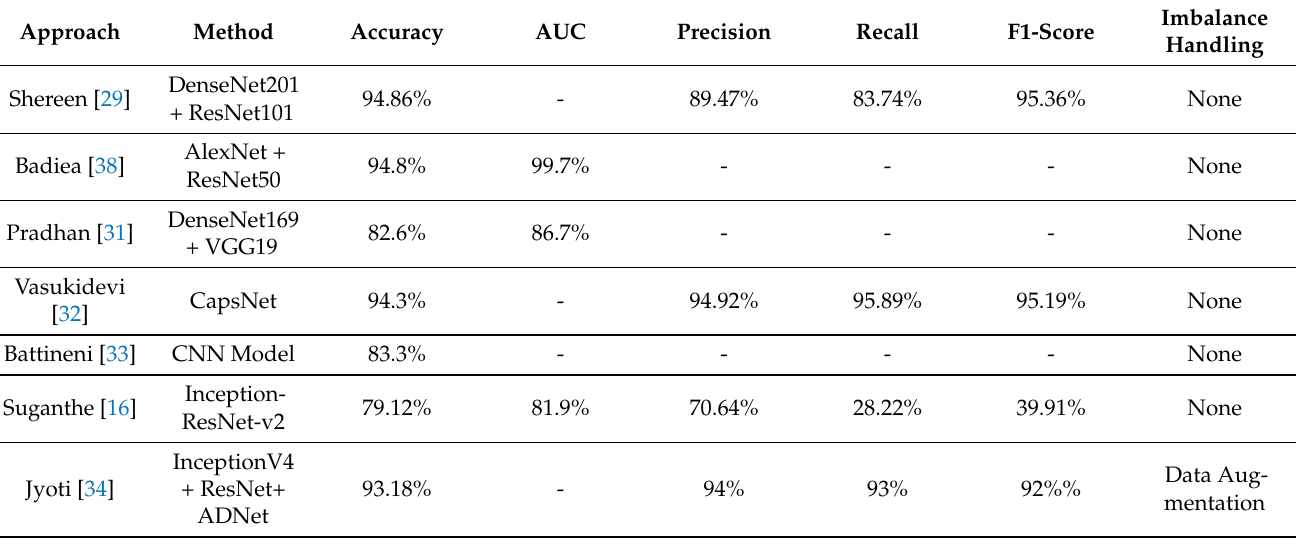
Table 1. A literature evaluation of current cutting-edge approaches used in AD detection and classification.